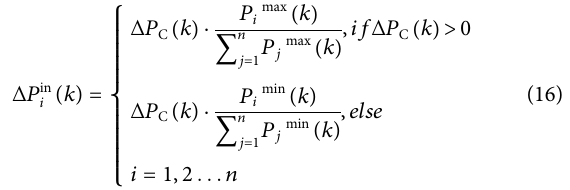
Figure 8. The PROP is an engineering application approach that only distributes the power command to the regulation resources according to their regulation power